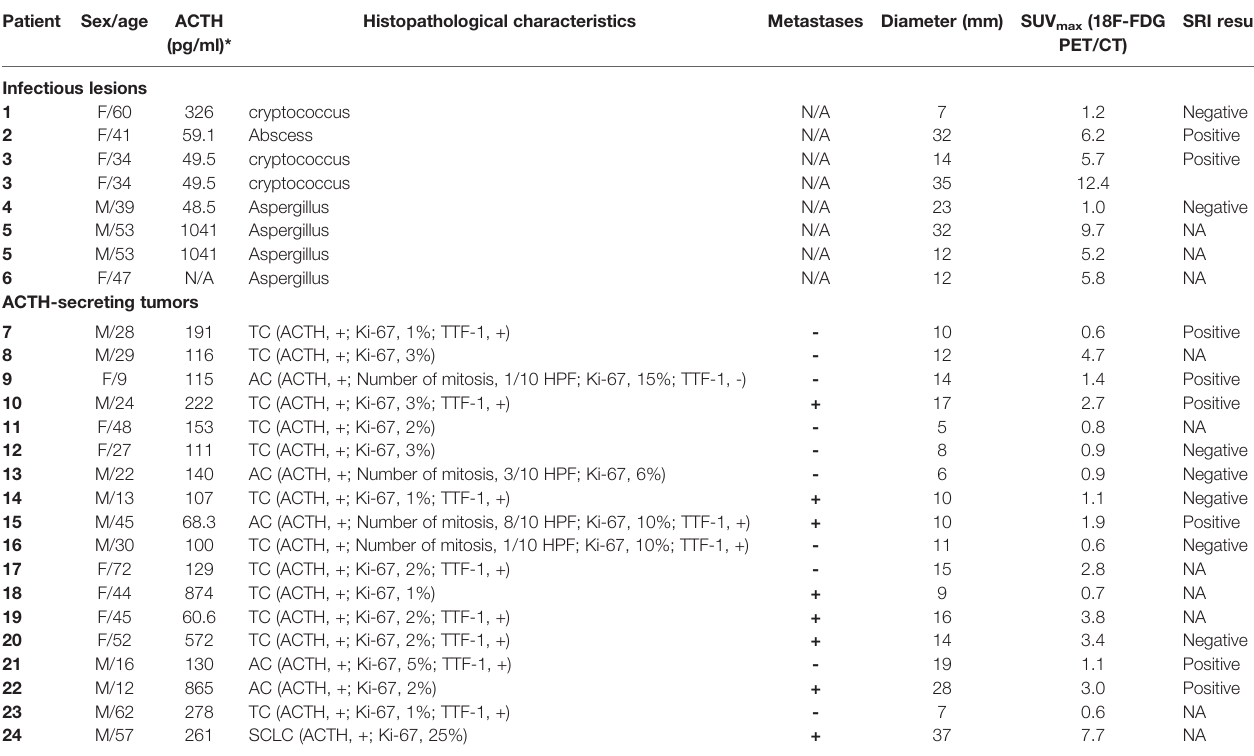
TABLE 1 | Clinical features of ectopic Cushing syndrome patients, including histopathological characteristics, metastases, size, and SUV max of lesions. Patient Sex/age ACTH (pg/ml)*